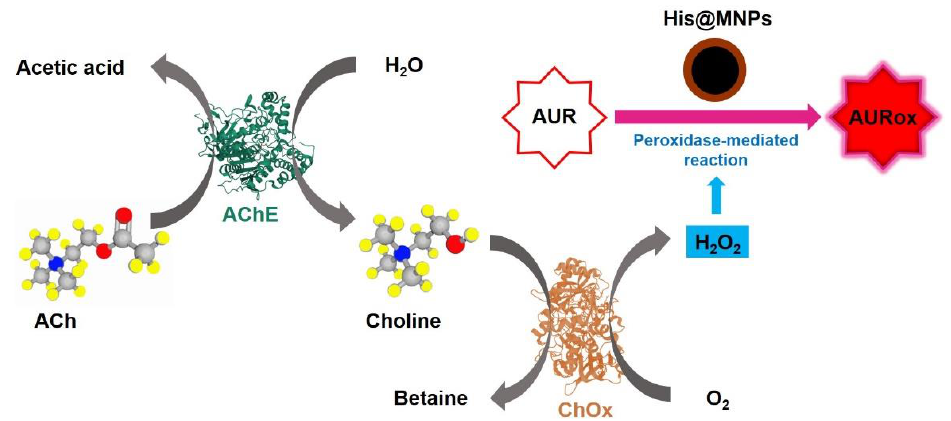
Scheme 1 . Schematic illustration of ACh detection utilizing multiple enzymes and peroxidase-